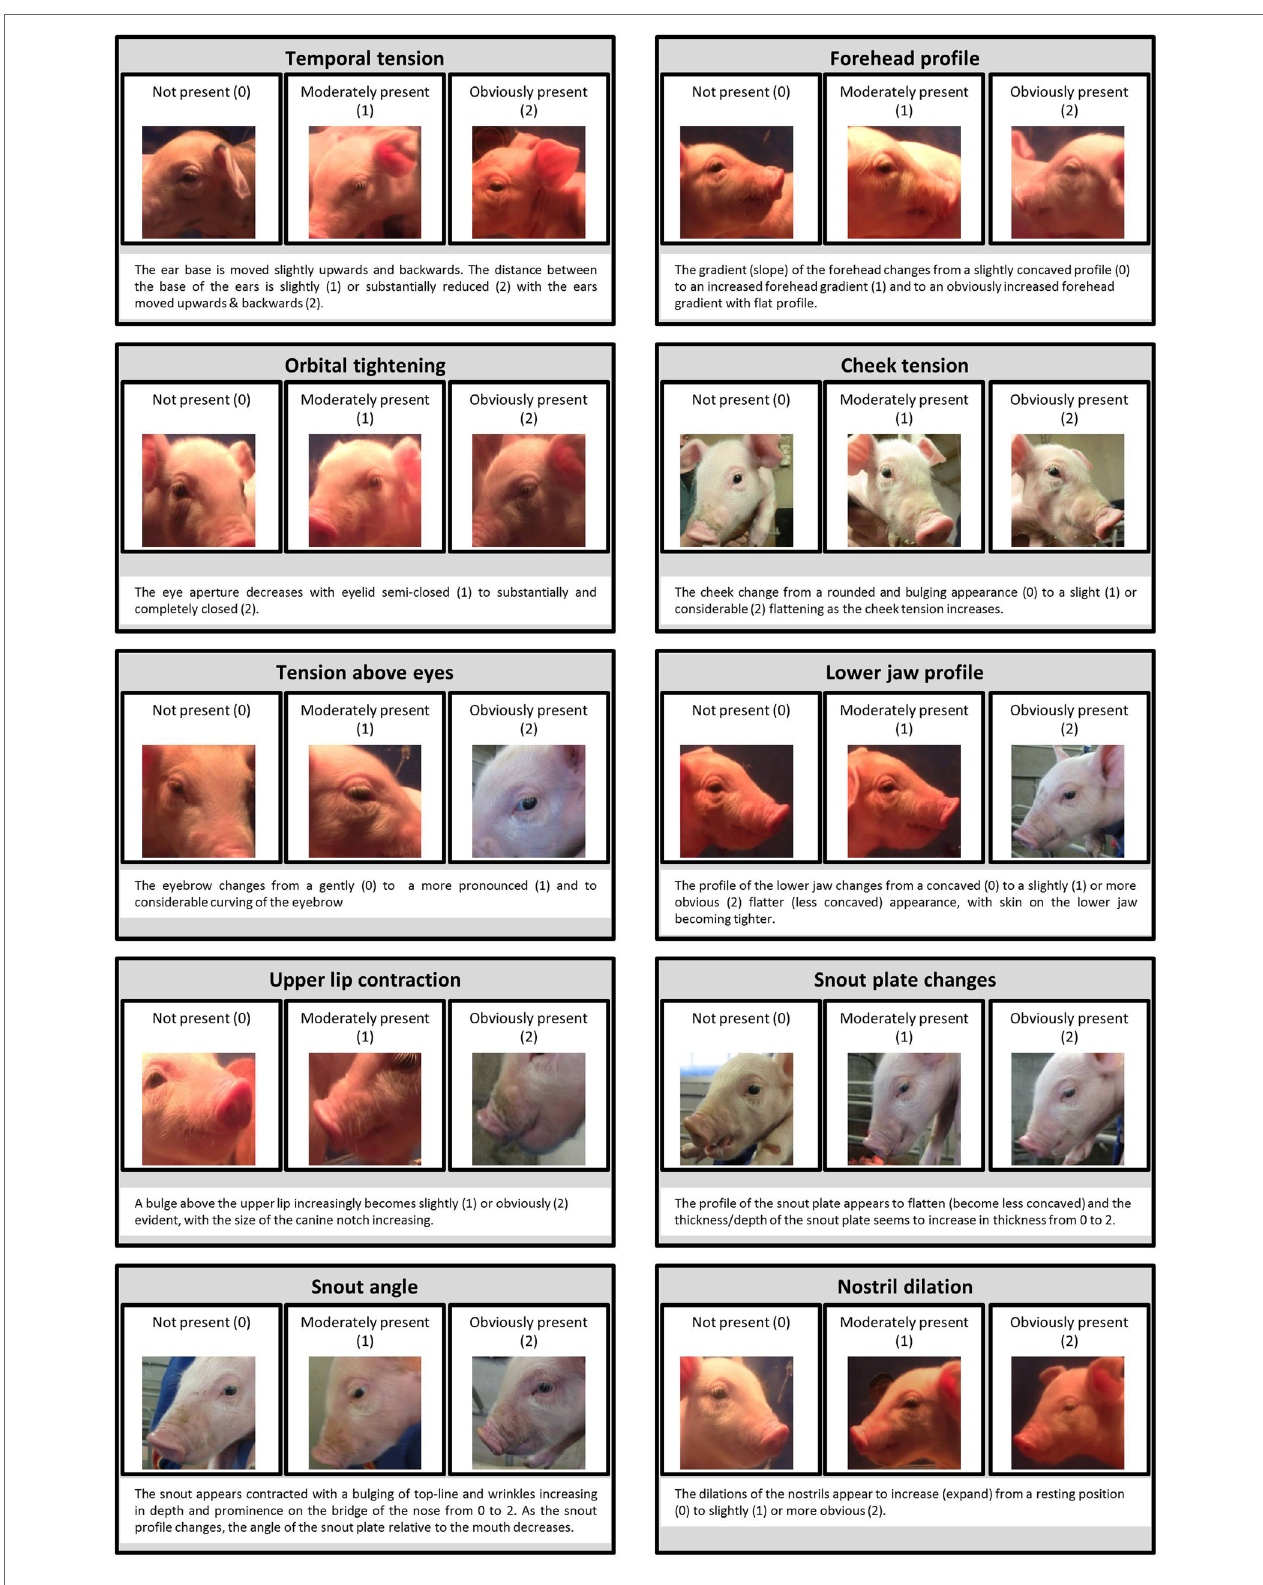
FigUre 3 | collection of images and explanations for each of the 10 facial action units (FaUs) included in the development of the Piglet grimace scale . For each FAU, an explanation of the 3-point scale is included (0 = not present, 1 = moderately present, 2 = obviously